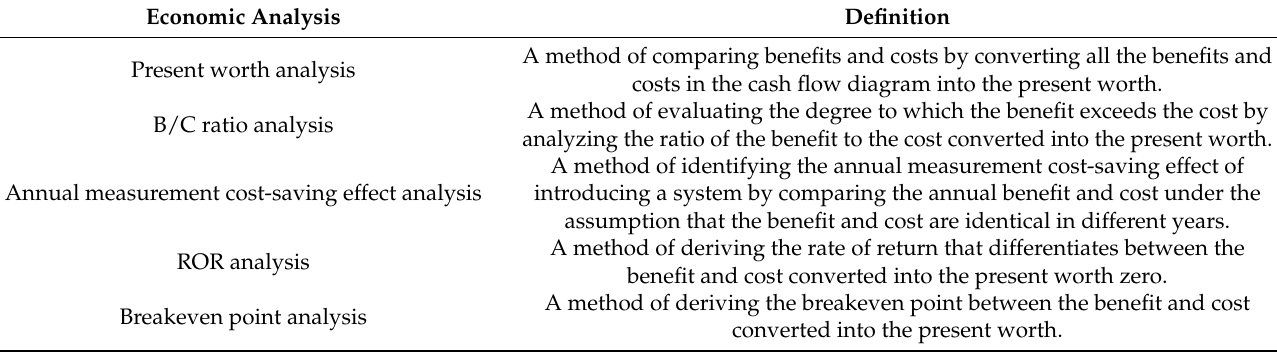
Table 9. Economic analysis definitions.